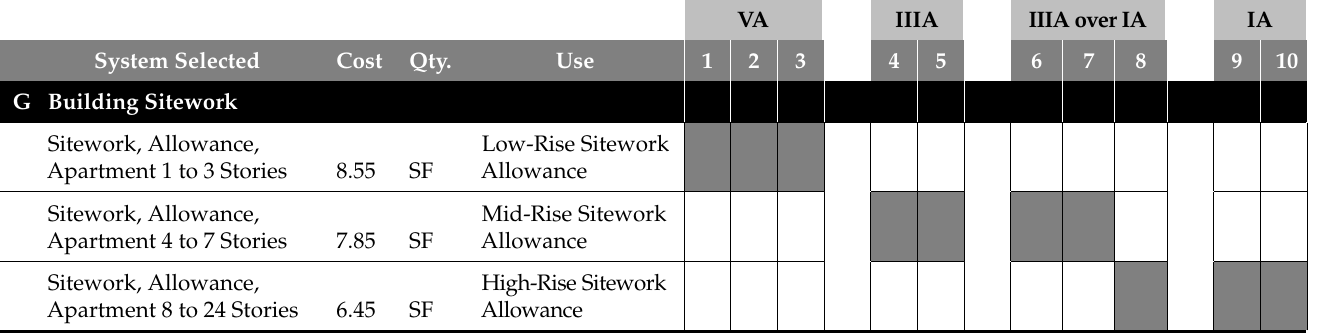
Table 6. Sitework Systems, Costs, and Designated